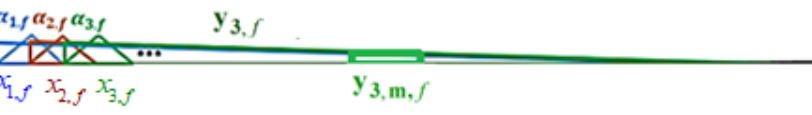
Figure 2. The schematic of three consecutive and overlapped short frames x 1, f , x 2, f , x 3, f . The short frame and subsequently their extended frames y 1, f , y 2, f , y 3, f are multiplied by the weights α 1, f , α 2, f , α 3, f , respectively. The extended frame y 3, f and one of its sub-frames y 3, m , f are also